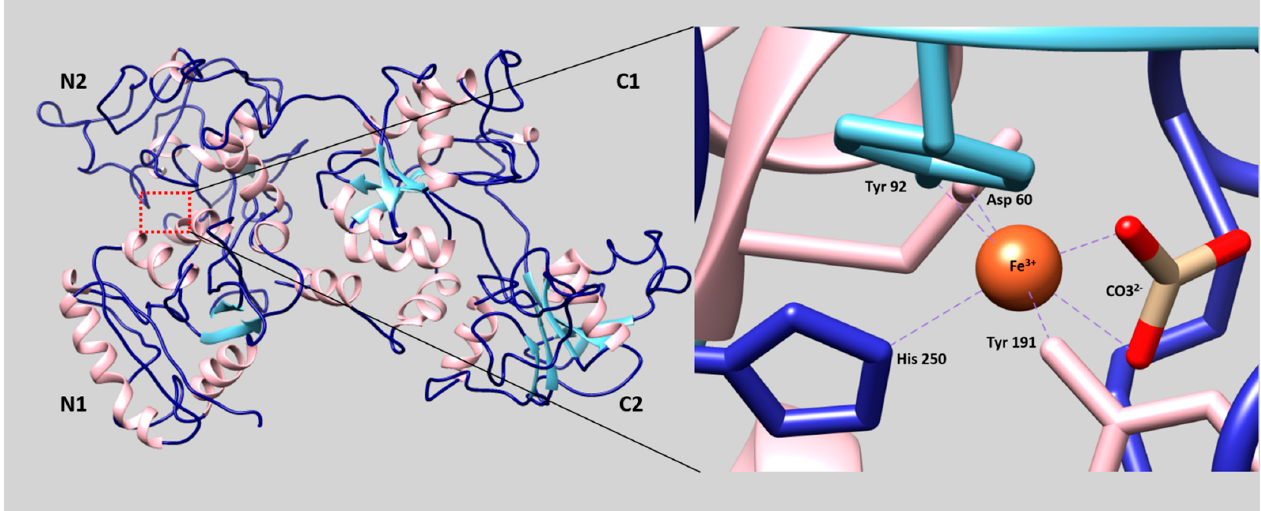
Figure 1. Representation of the tertiary structure of ovotransferrin. The subdomains of each lobe are indicated by N1, N2, C1, and C2. On the left, an enlargement of the binding site of the N lobe shows the binding of iron by its six ligands. The images were produced using the UCSF chimera package [45] from the tertiary structure of the ovotransferrin (PDB ID: 1AIV) [42].